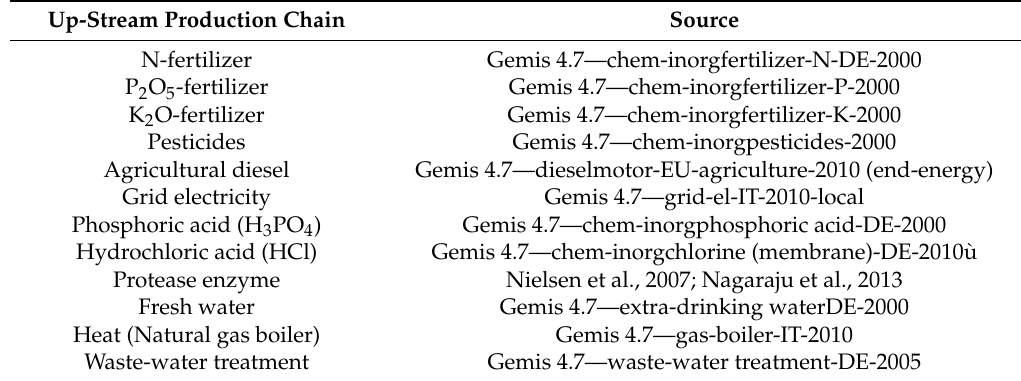
Table 1. Up ‐ stream processes used for the LCA implementation of the two production chains of biostimulants.